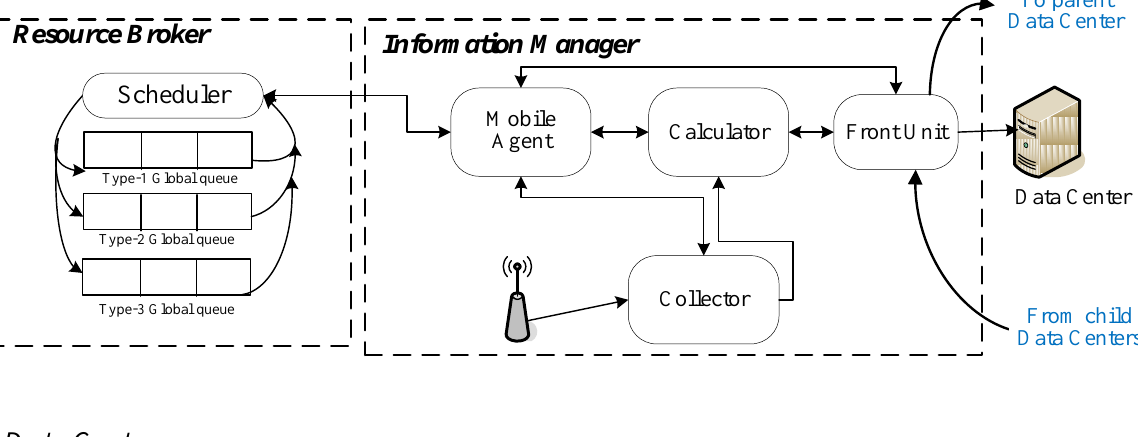
Figure 2. The components of the MCI server.